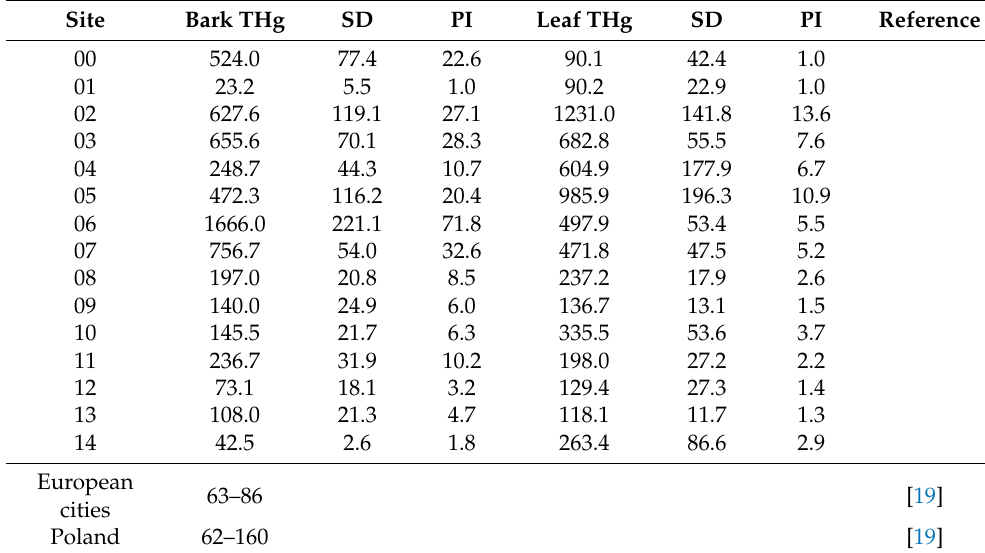
Table 1. Statistical summary of THg concentrations for bark and leaves, expressed in ng g − 1 . Site 01 is considered as background. The pollution index (PI) is expressed as the ratio C sample /C background . Reference concentration as referred for Platanus acerifolia . SD: standard